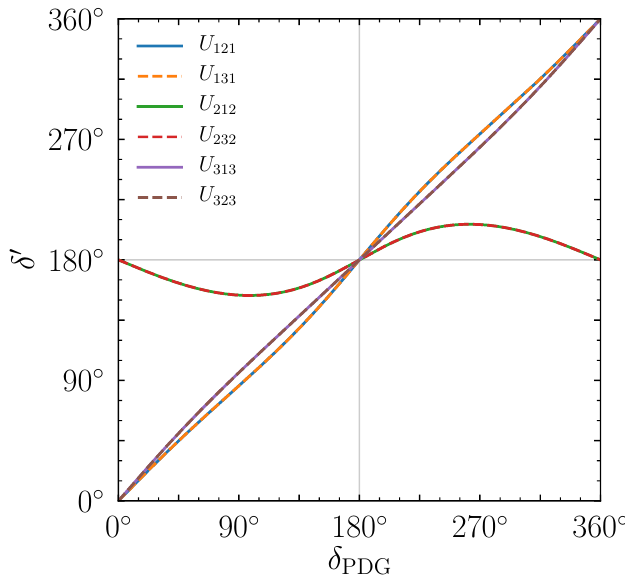
Figure 6 . The same as the left panel of figure 1 except for parameterizations with a repeated rotation. Note that δ 0 in the parameterizations U